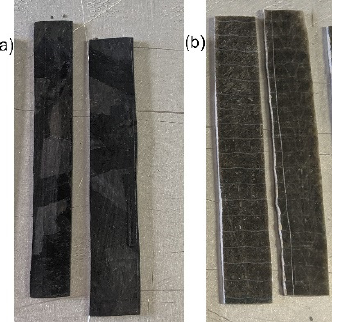
Figure 7. ( a ) flat HexMC specimens, ( b ) FQQ specimens. Table 3. Specimen dimensions.